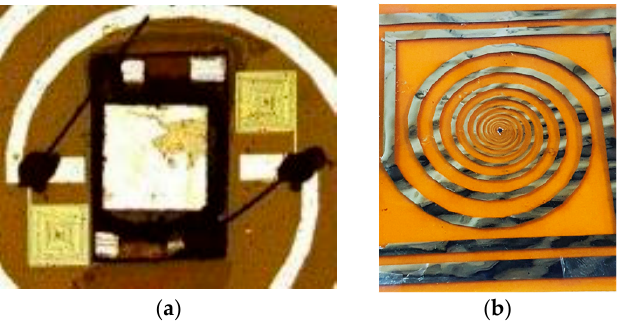
Figure 9. ( a ) Optical image after gluing gold wires with epoxy conductive paste; ( b ) final foil of the experimental RFID model.